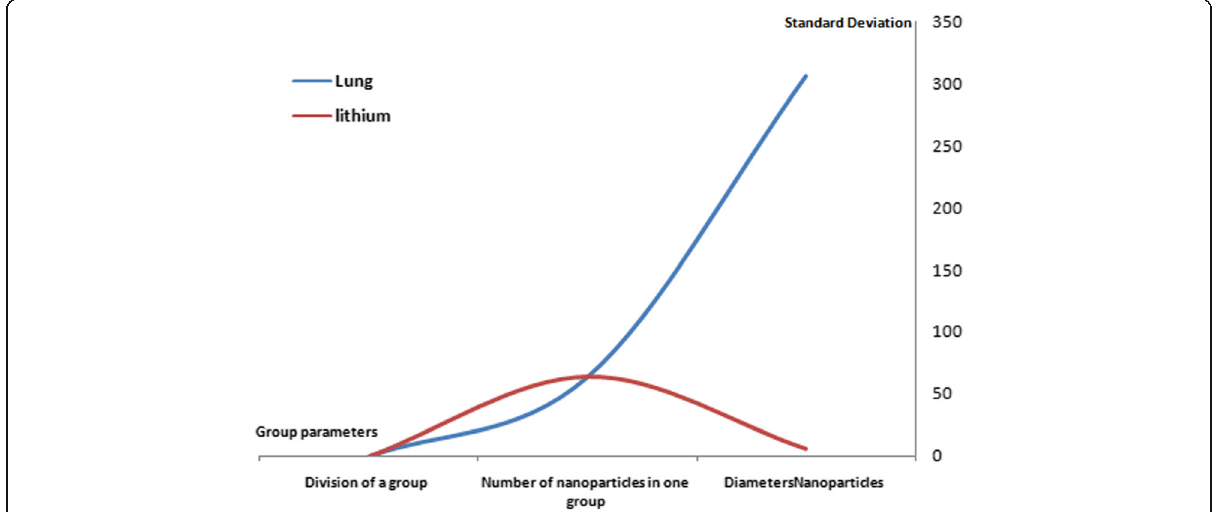
Fig. 12 The standard deviation of lung and lithium nanoparticles